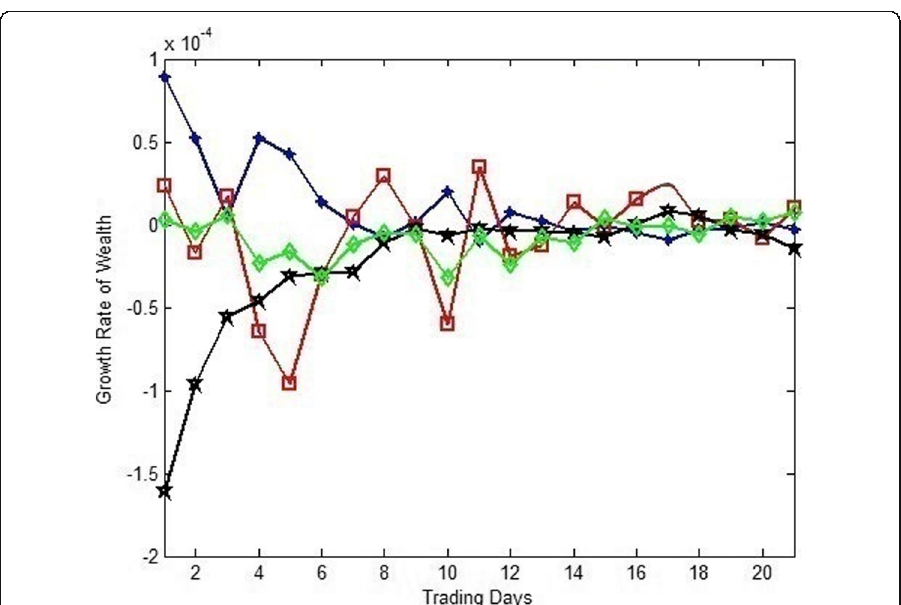
Fig. 5 Wealth growth rate of investors. Blue line: informed traders; Red line: technical traders; Black line: noise traders; Green line: arbitrage traders